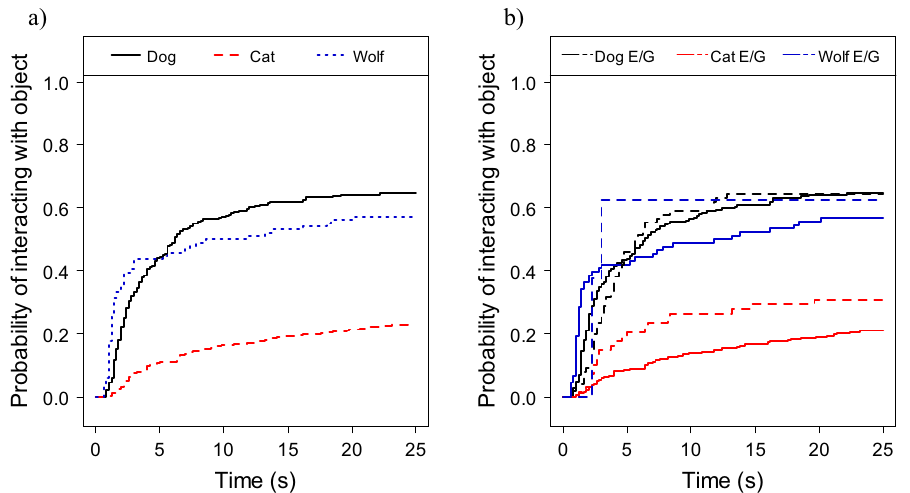
Figure 4. ( a ) Species differences: dog puppies and wolf pups interacted more likely with the object than kittens; ( b ) species-specific effects of condition (experimental condition, E, illustrated with solid, and ghost condition, G, with dotted line) on the probability of interacting with the object in dog puppies, kittens and wolf pups: kittens and, to a lesser extent, also wolf pups (but not dog puppies) interacted with the object more likely in the ghost trials than in the experimental